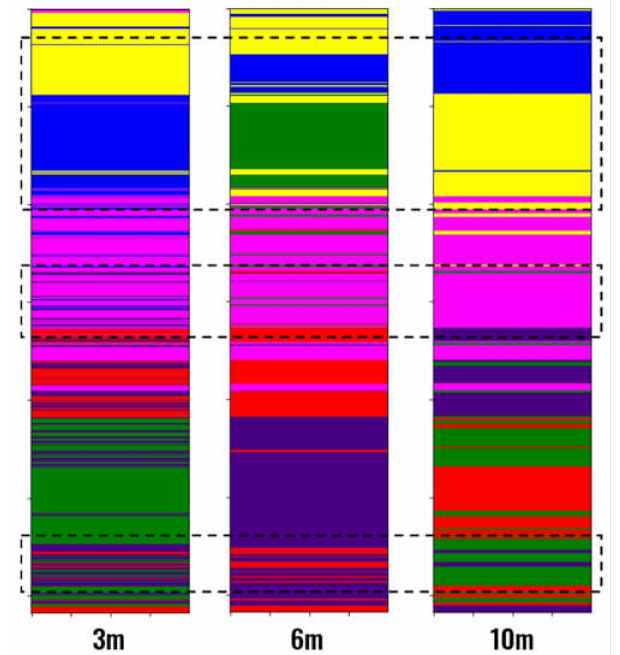
Figure 21. Results for different window sizes and k-Means with 6